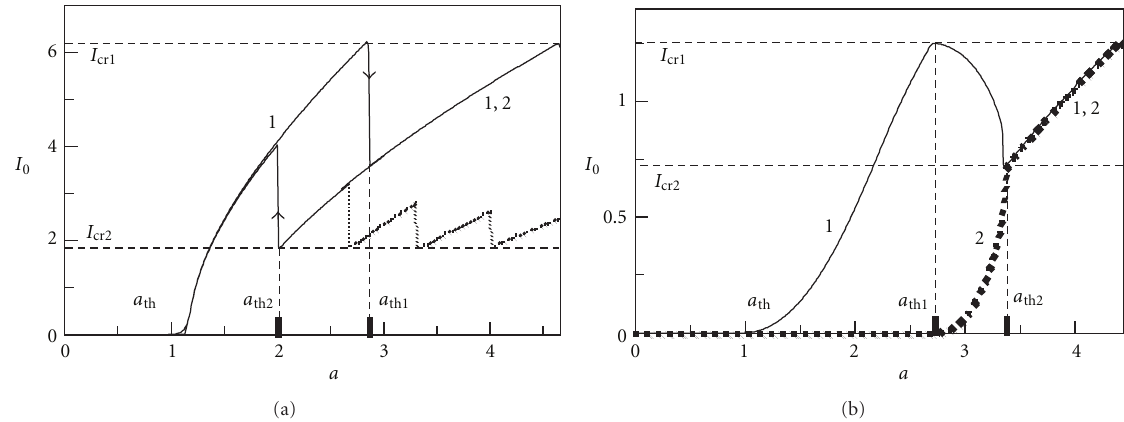
Figure 8: Dependences of the peak intensities I 0 for two intracavity pulses in established operation on pumping a for hard (a) and soft (b) regimes of excitation and annihilation of the second soliton. The dependences I 0 = I 0 ( a ) for first and second pulses are denoted by digits 1 and 2, respectively.